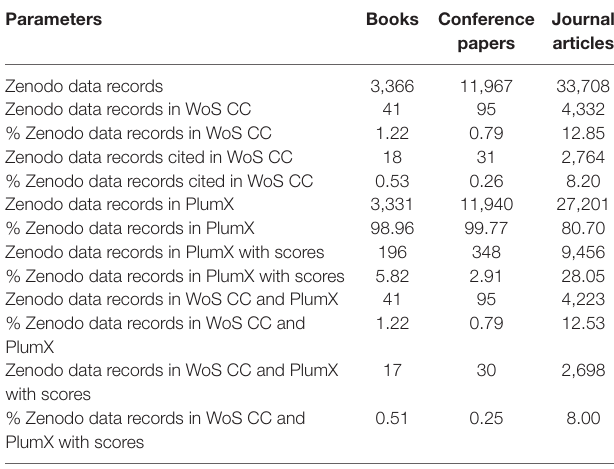
Table 2 | Coverage of Zenodo data records in WoS CC and PlumX (Zenodo data record types: books, conference papers, and journal articles—all publication